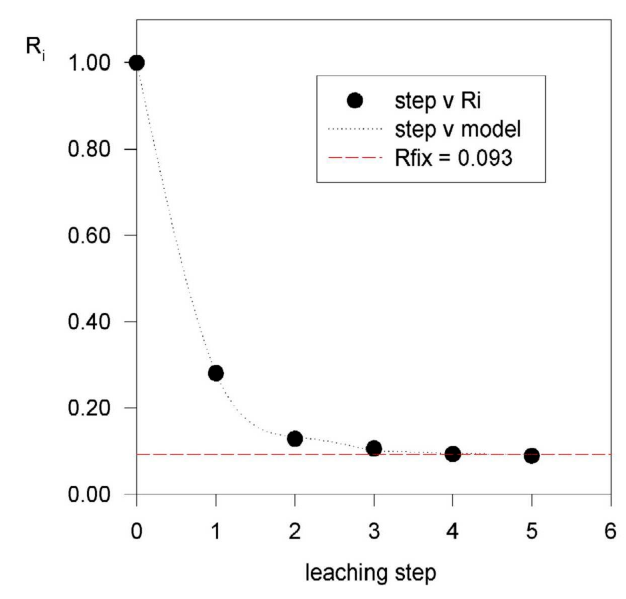
FIGURE 1. Sequential leaching of radiocaesium from montmorillonite by 1 M ammonium acetate (r = 100 ml/g, E = 0.21, and K d =